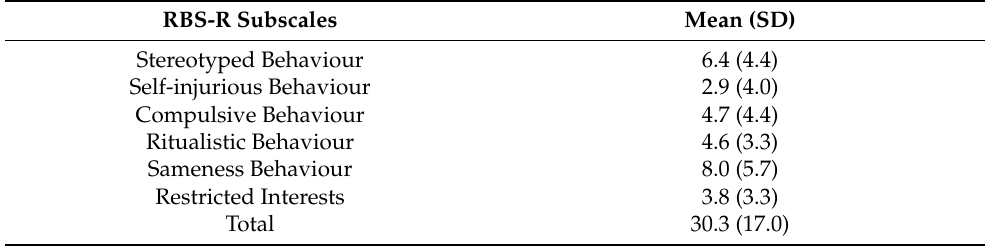
Table 3. Repetitive Behaviour Scale-Revised (RBS-R) mean subscales and total scores.